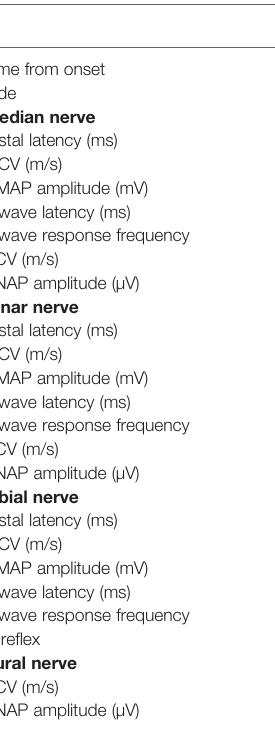
TABLE 1 | Dynamic changes in electromyography (EMG) before and after